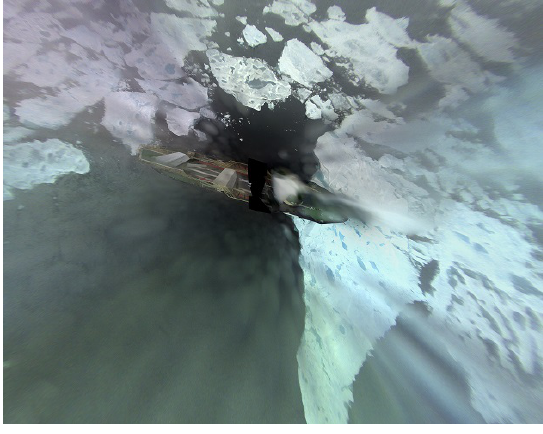
Figure 13: 360 degree panorama